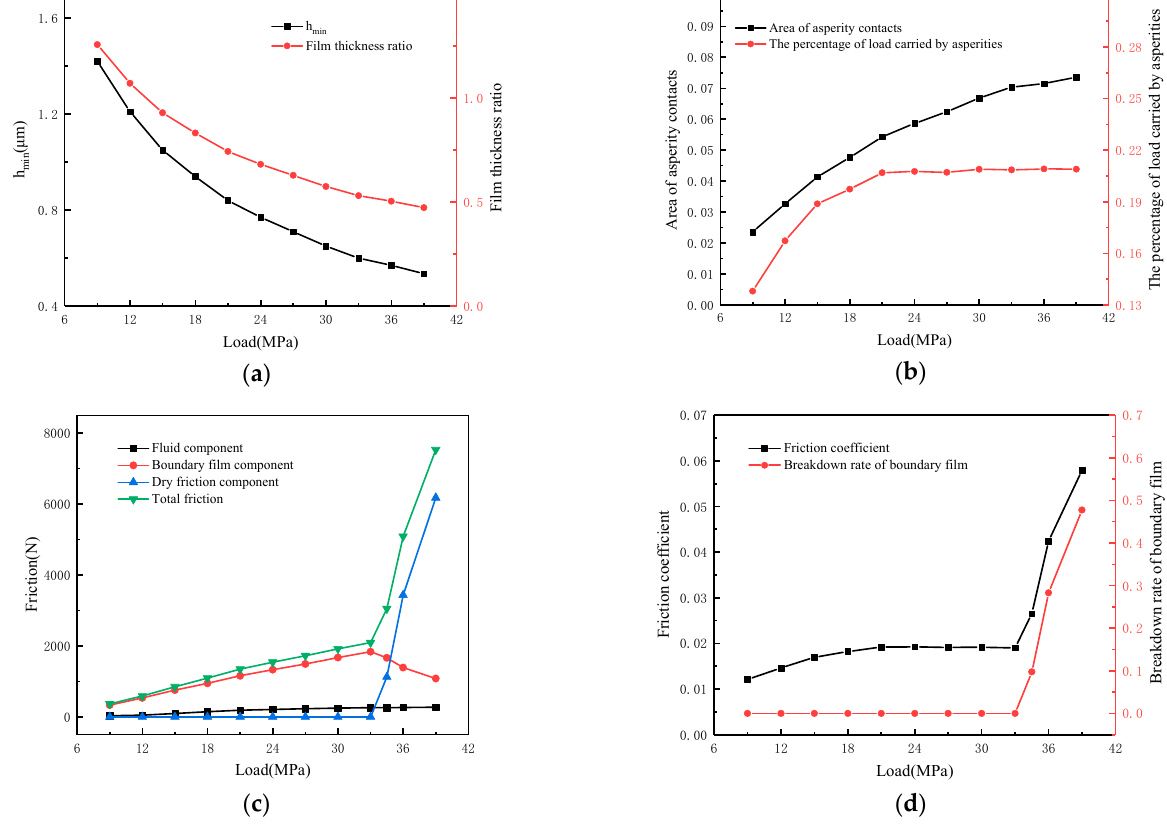
Figure 17. Influence of load on lubrication performance. ( a ) Calculated film thickness; ( b ) Calculated asperity contacts; ( c ) Calculated friction components; ( d ) Calculated friction coefficient.